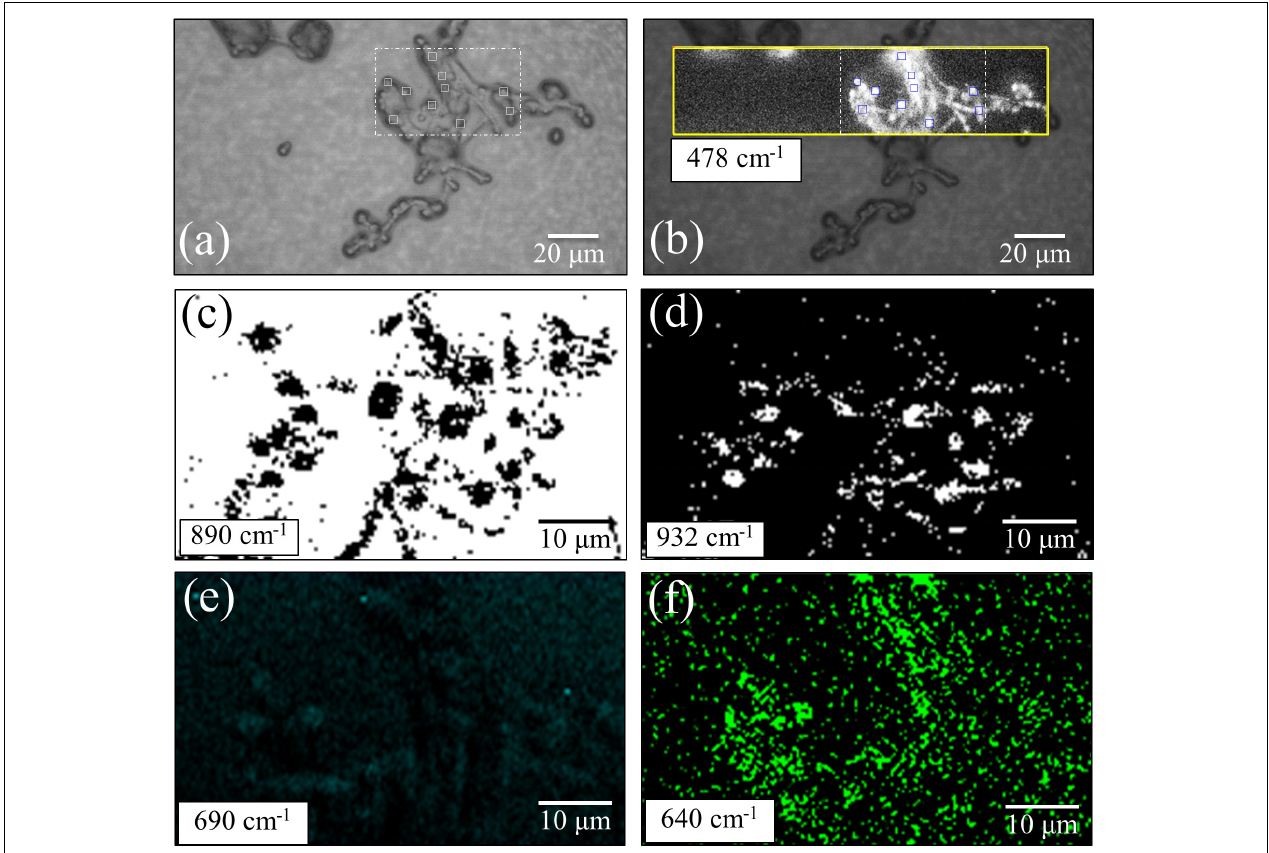
FIGURE 5 | (a) Optical micrograph of cultured C. albicans cells; spatially resolved Raman maps in: (b) glucose rings in membrane polysaccharides at 478 cm − 1 (in the yellow square region), (c) β -1, 3-glucans (in the white broken-line square region) at 890 cm − 1 (black spots on white background), (d) α -1, 3-glucans (in the broken-line square region) at 932 cm − 1 (white spots on black background), (e) S-containing amino acids (in the white broken-line square region) at 690 cm − 1 , and (f) chitin at 640 cm − 1 (in the white broken-line square region). The 10 smaller square areas located in a,b represent the regions used for PCA